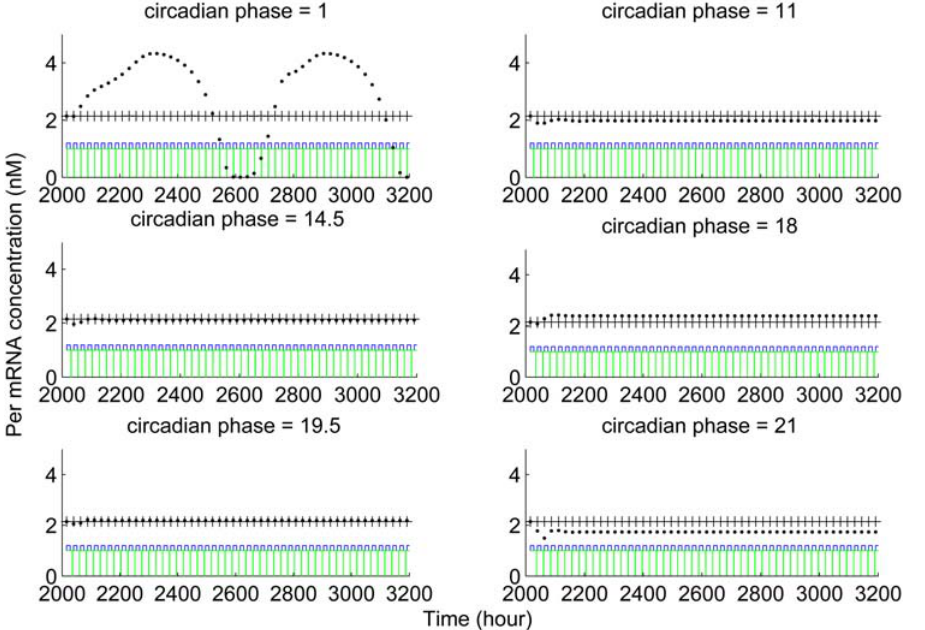
Figure 6. Transcriptional inhibition induced changes at different circadian phases under LD cycle conditions. The LD cycle is first introduced into the circadian model, and the resulting model is simulated. When the model reaches equilibrium, transcriptional inhibitions are introduced into the model at different circadian phases. The system changes after inhibition imposition is depicted by the difference in Per mRNA level at light onset between pre- and post-inhibition imposition. ‘‘ + ’’ denotes Per mRNA level at light onset before inhibition imposition; ‘‘.’’ denotes Per mRNA level at light onset after inhibition perturbation.